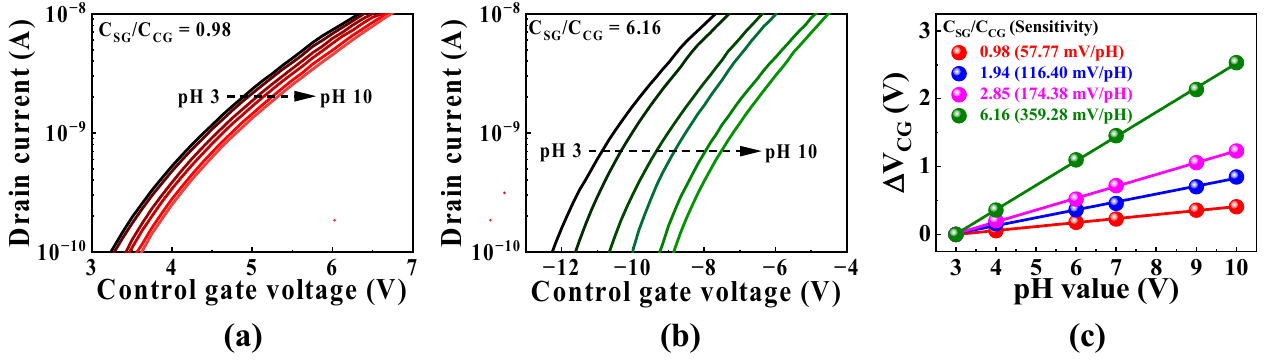
Figure 5. Transfer characteristics curves of the a-IGZO coplanar dual-gate TFT pH sensor in various pH buffer solutions for C SG /C CG of ( a ) 0.98 and ( b ) 6.16. ( c ) pH sensitivity for various C SG /C CG values (I Read = 1 nA).